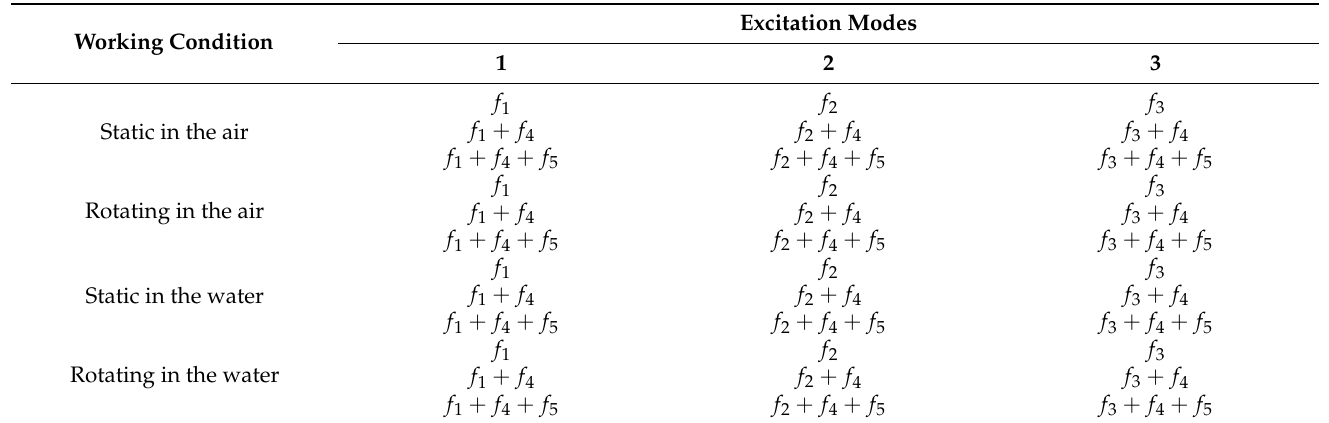
Table 2. Cavitation simulation test of